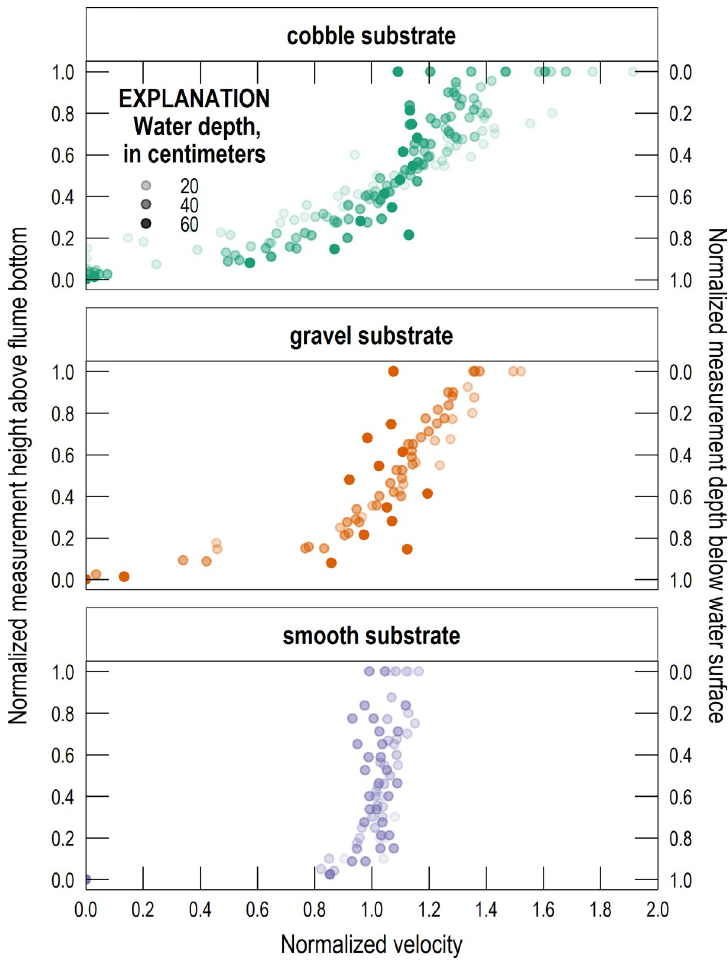
Fig 1. Vertical velocity profiles for each set of conditions tested in the flume. Measurement depth is normalized by water depth and the result subtracted from 1 to obtain normalized measurement height above the bottom, and velocity is normalized by depth-averaged velocity. The point opacity is proportional to water depth, with increasing opacity corresponding to increasing water depth.